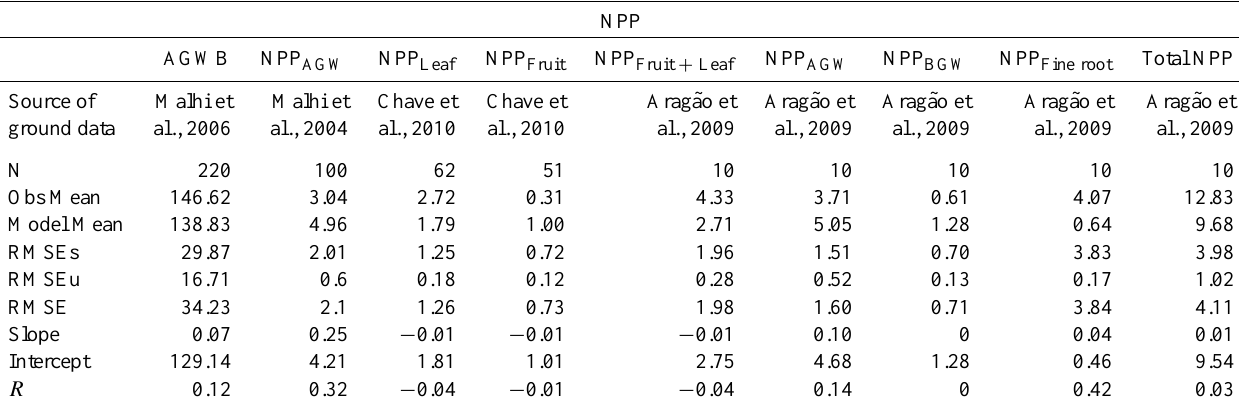
Table 1. comparison of ORCHIDEE outputs (AGWB in tonsC/ha, NPP and NPP organs in tonsC/ha/year) with ground measurements.